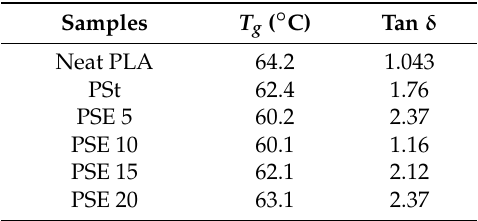
Figure 8. Tan δ of neat PLA, PSt, and PSE blends. Table 4. Tan δ and T g of neat PLA, PSt, and PSE blends obtained from dynamic mechanical analyzer (DMA).